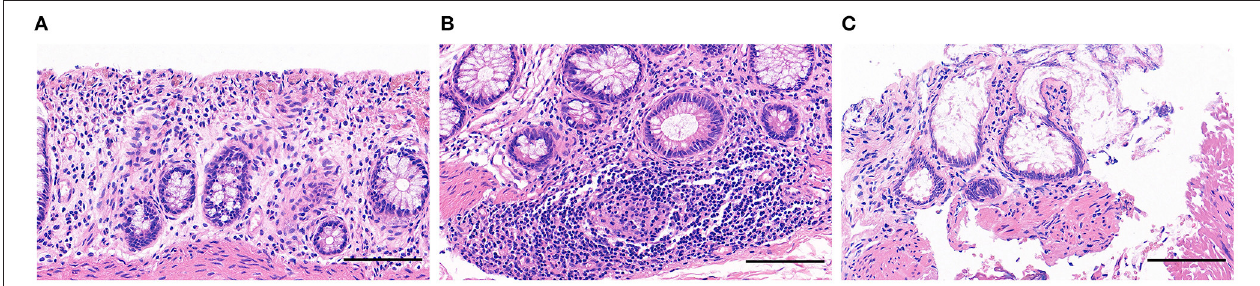
FIGURE 2 | Pathological manifestation of adjacent marginal tissue from the perforated intestine. (A) Mild inflammatory cell infiltration, with focal mucosal ischemic necrosis. (Grade I); (B) HAEC Grade II: Infiltration of a large number of inflammatory cells with crypt dilation and mucin retention. (Grade II); (C) Infiltration of a large number of inflammatory cells with crypt abscesses and epithelium destruction. (Grade